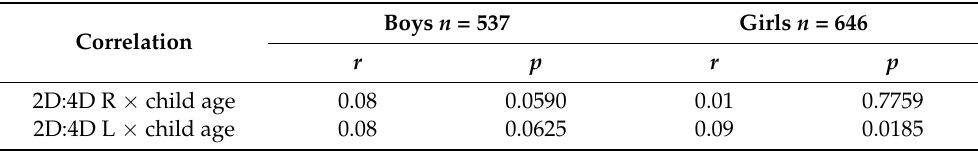
Table 2. Evaluation of correlations between right and left hand digit ratios in children and their chronological age.